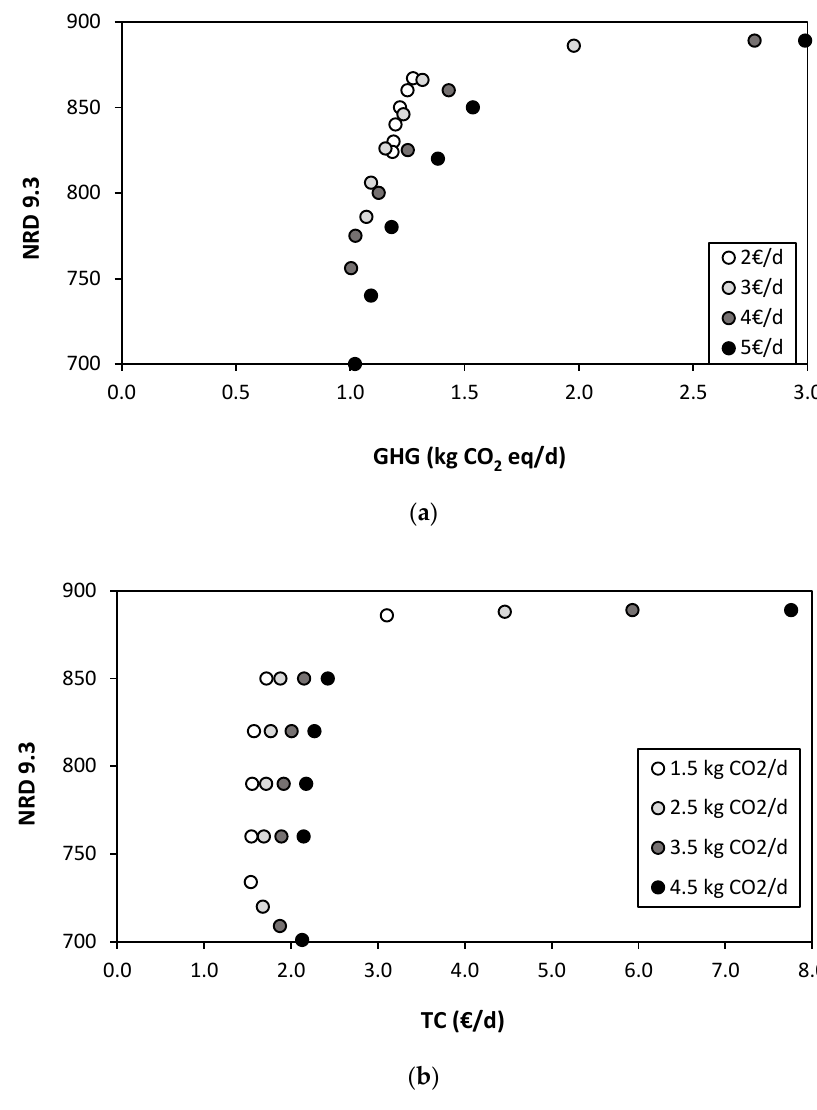
Figure A1. Cumulative frequency of the NRD9.3w values of the different pre-defined diets in the Montecarlo analysis.